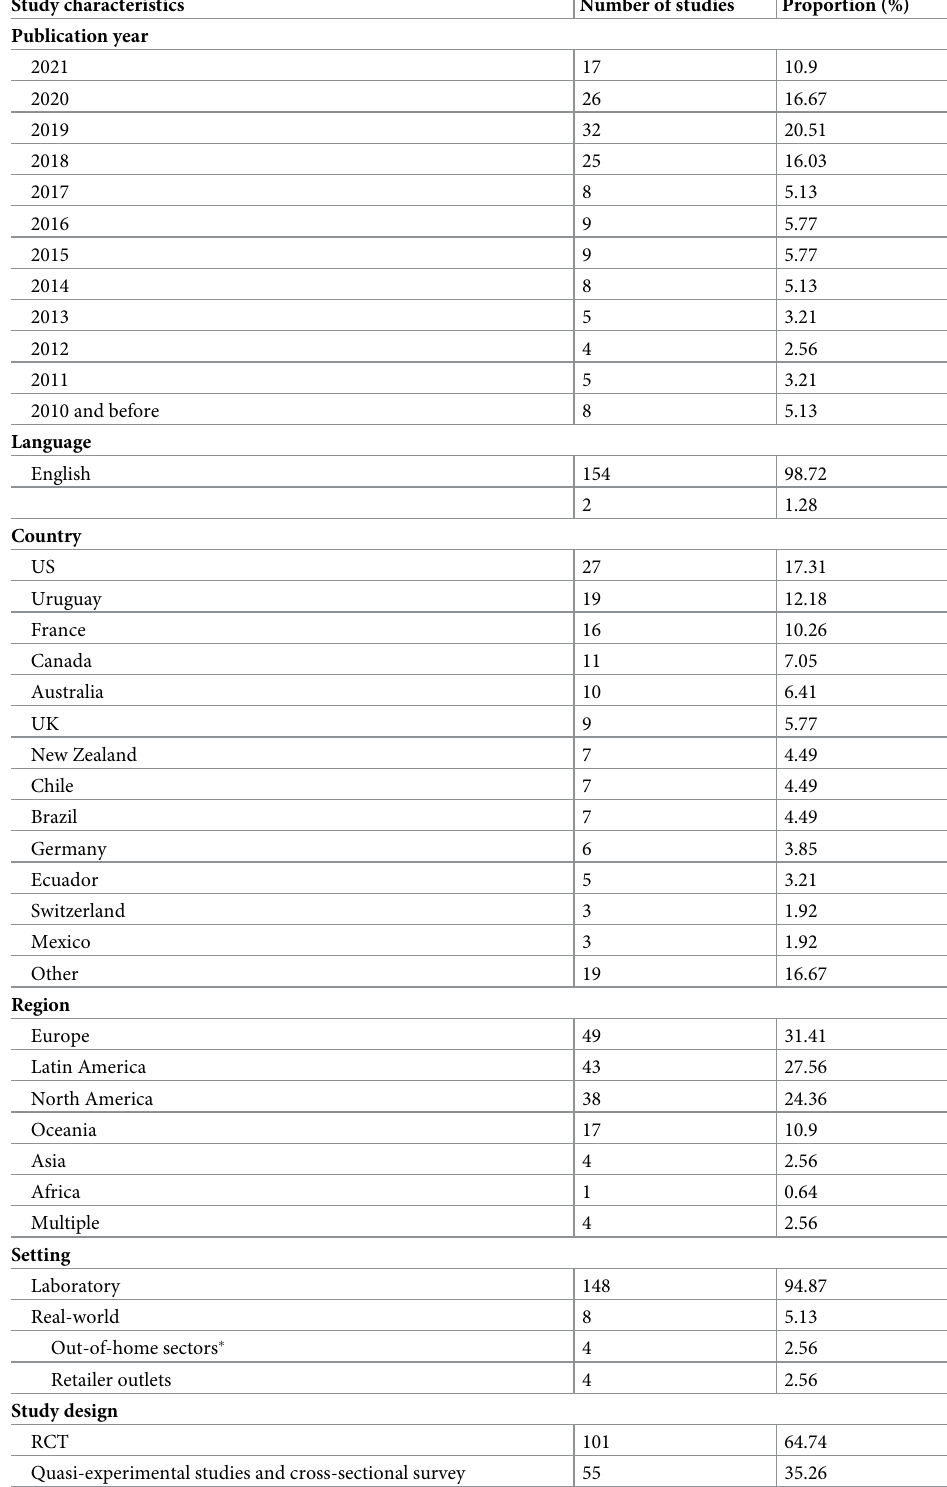
Table 2. Characteristics of studies included in the systematic review ( n =